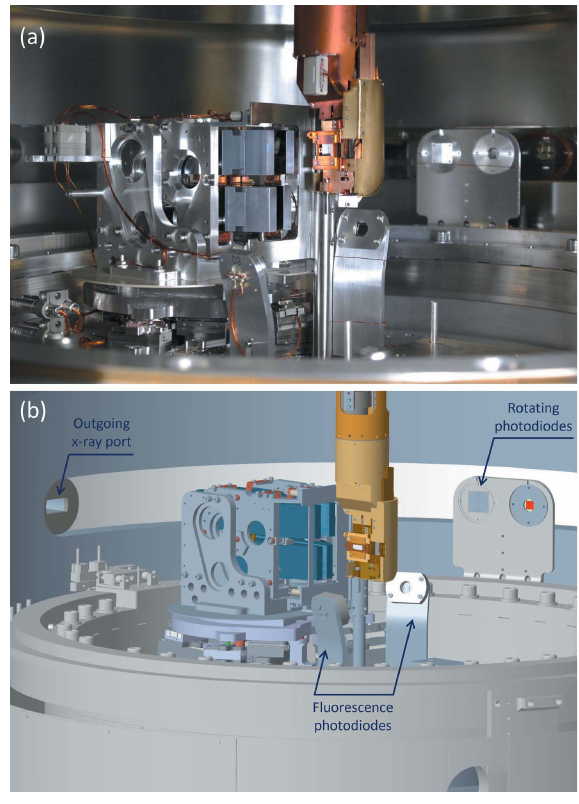
Figure 16 The in-vacuum components inside the I21 sample vessel. ( a ) A photograph through one of the large viewports on the sample vessel and ( b ) an engineering rendering of a similar view in the CAD model.